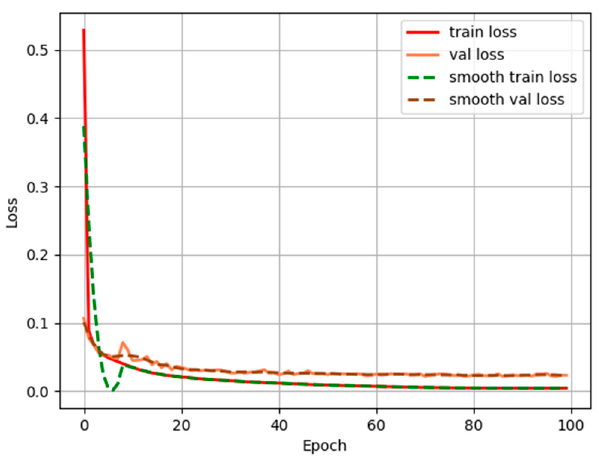
Figure 8. Loss–function curve.